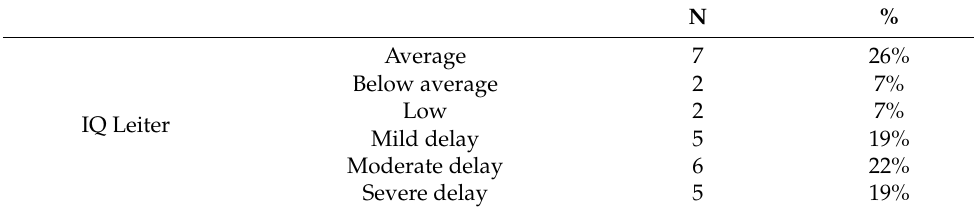
Table 10. IQ test